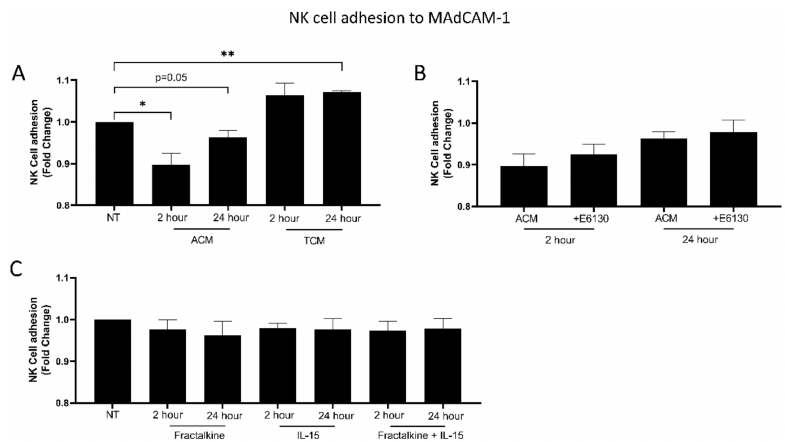
Figure 5. ACM slightly but significantly reduces NK cell adhesion to gut-homing adhesion molecule MAdCAM-1 whilst TCM significant increases it. ( A ) Bar chart showing the fold-change adhesion of NK cells to MAdCAM-1 following no treatment (NT), treatment with adipose conditioned media (ACM) or tumour conditioned media (TCM) for 2 or 24 h ( n = 3–6). ( B ) Bar chart showing the fold-change adhesion of NK cells to MAdCAM-1 following treatment with adipose conditioned media (ACM) for 2 or 24 h with and without 1 h pre-treatment with 5 nM CX3CR1 antagonist E6130 ( n = 3–6). ( C ) Bar chart showing the fold-change adhesion of NK cells to MAdCAM-1 following no treatment (NT), or treatment with 100 ng/mL of fractalkine and/or IL-15 ( n = 3–6). Paired t -test, * p < 0.05, ** p <